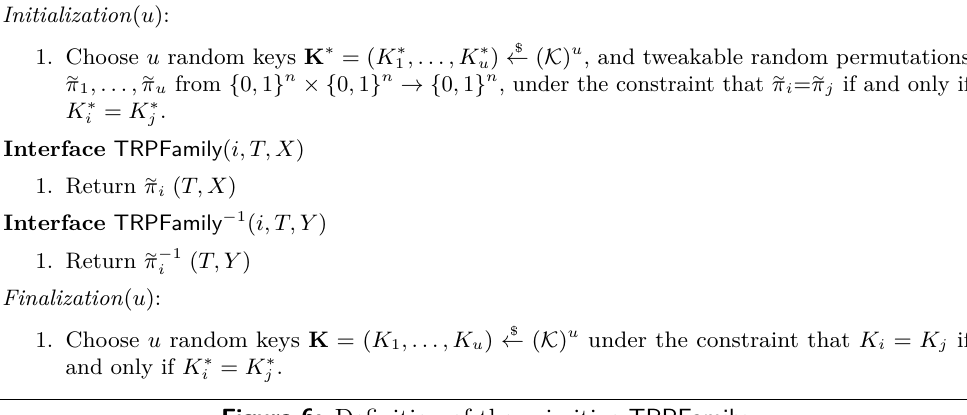
Figure 6: Definition of the primitive TRPFamily